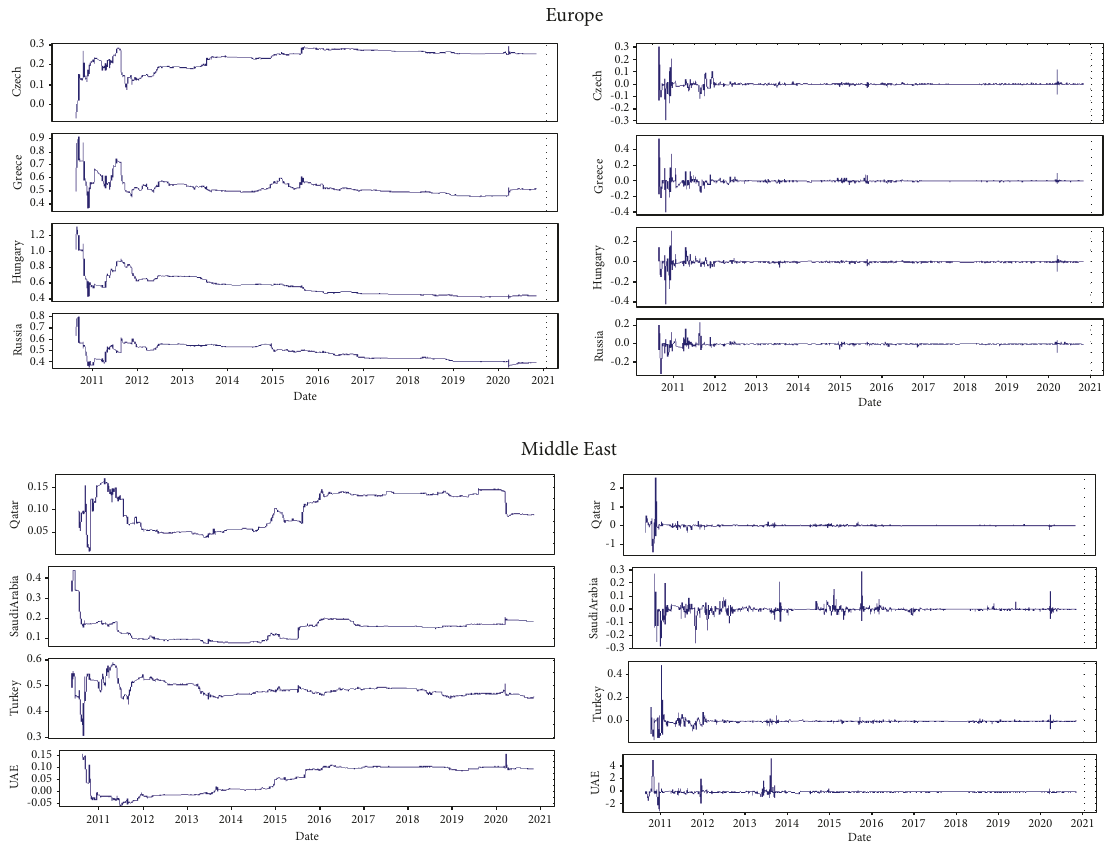
Figure 1: Graphical representation of equity betas of time series